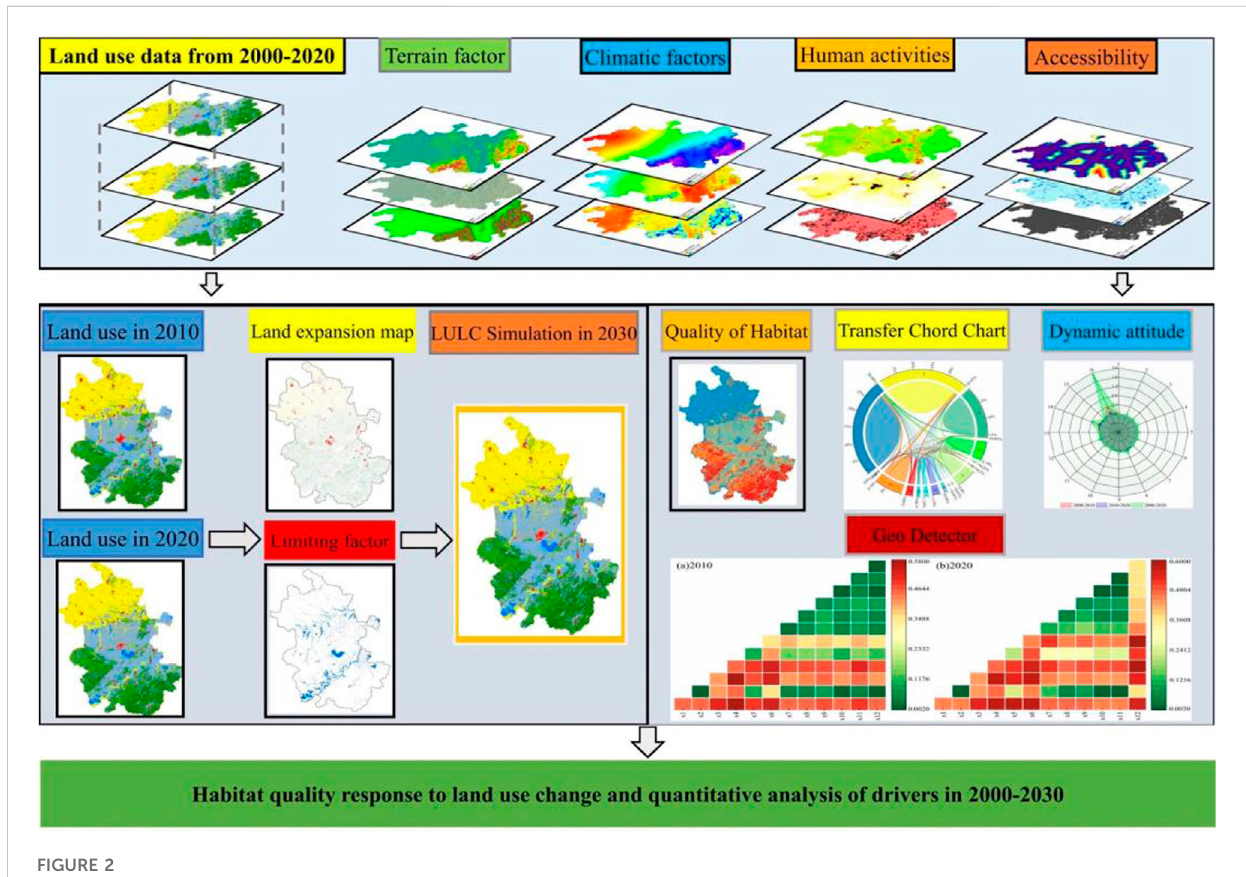
FIGURE 2 Research framework.